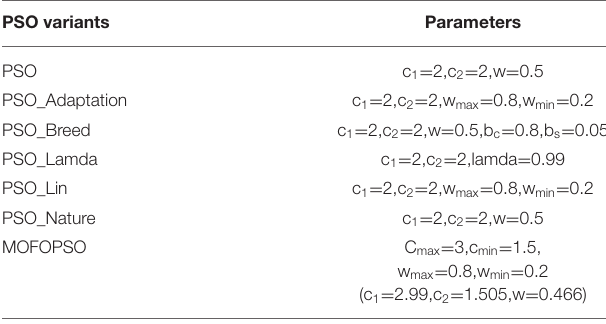
TABLE 4 | The relevant parameters of various algorithms.